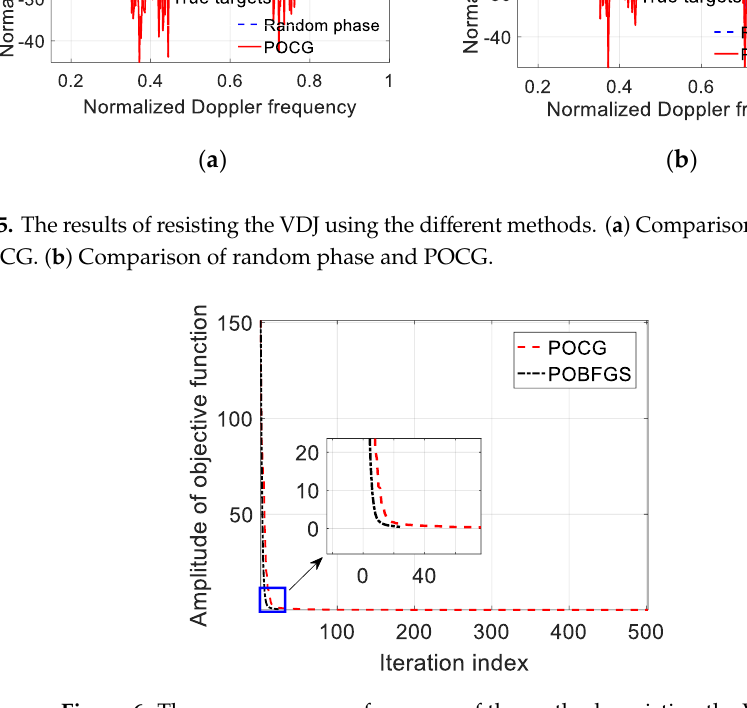
Figure 6. The convergence performance of the methods resisting the VDJ.